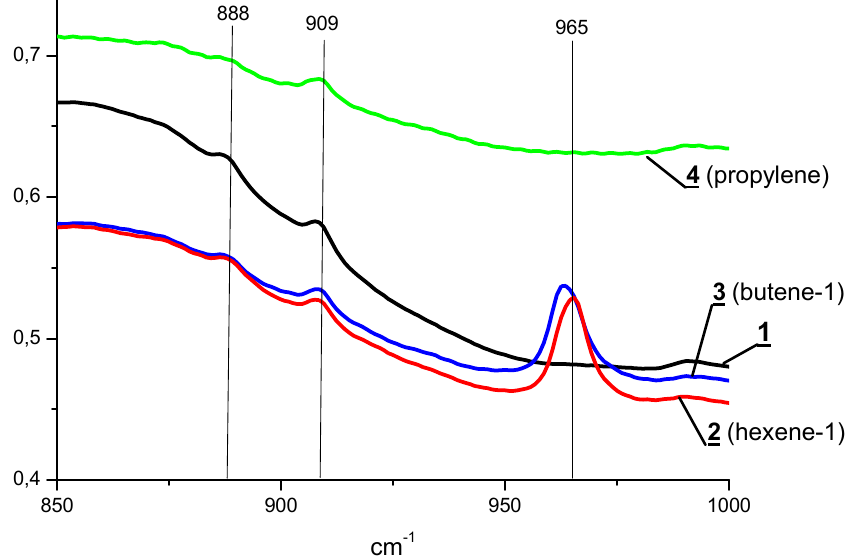
Figure 9. IR spectra of polymers, presented in Table 3. (Numbers of the spectra correspond to the experiment numbers in Table 3).